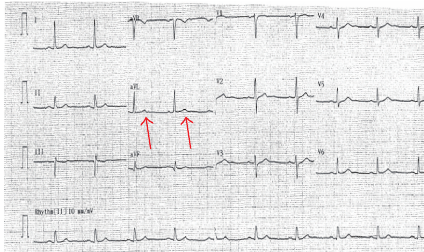
Figure 5: Follow-up ECG: patient returned to the cardiology office and his repeat ECG demonstrated the upright T waves in lead aVL after the stent